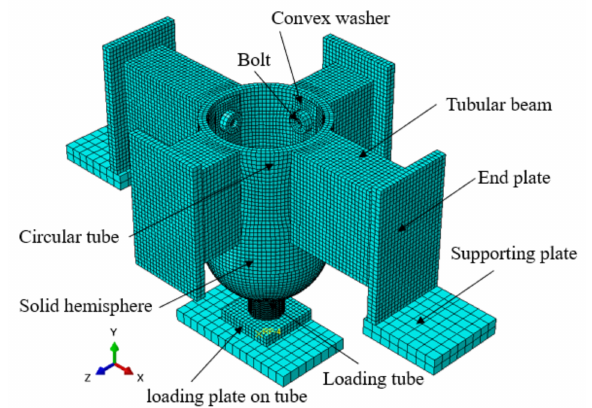
Figure 3. Finite element (FE) model of BBC joint under